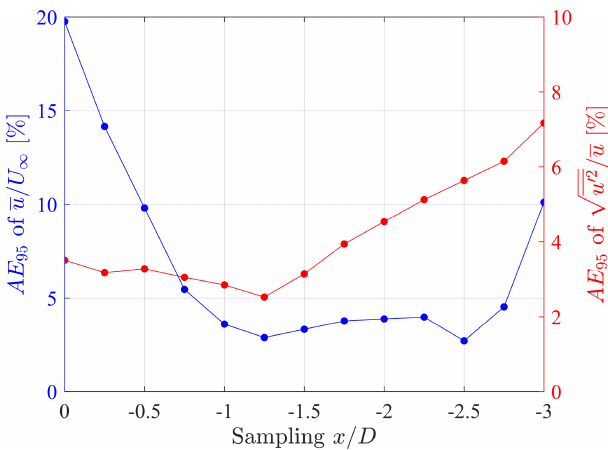
Figure 21. AE 95 of mean velocity and turbulence intensity for F01– F04 as a function of the upstream sampling location of the LiSBOA